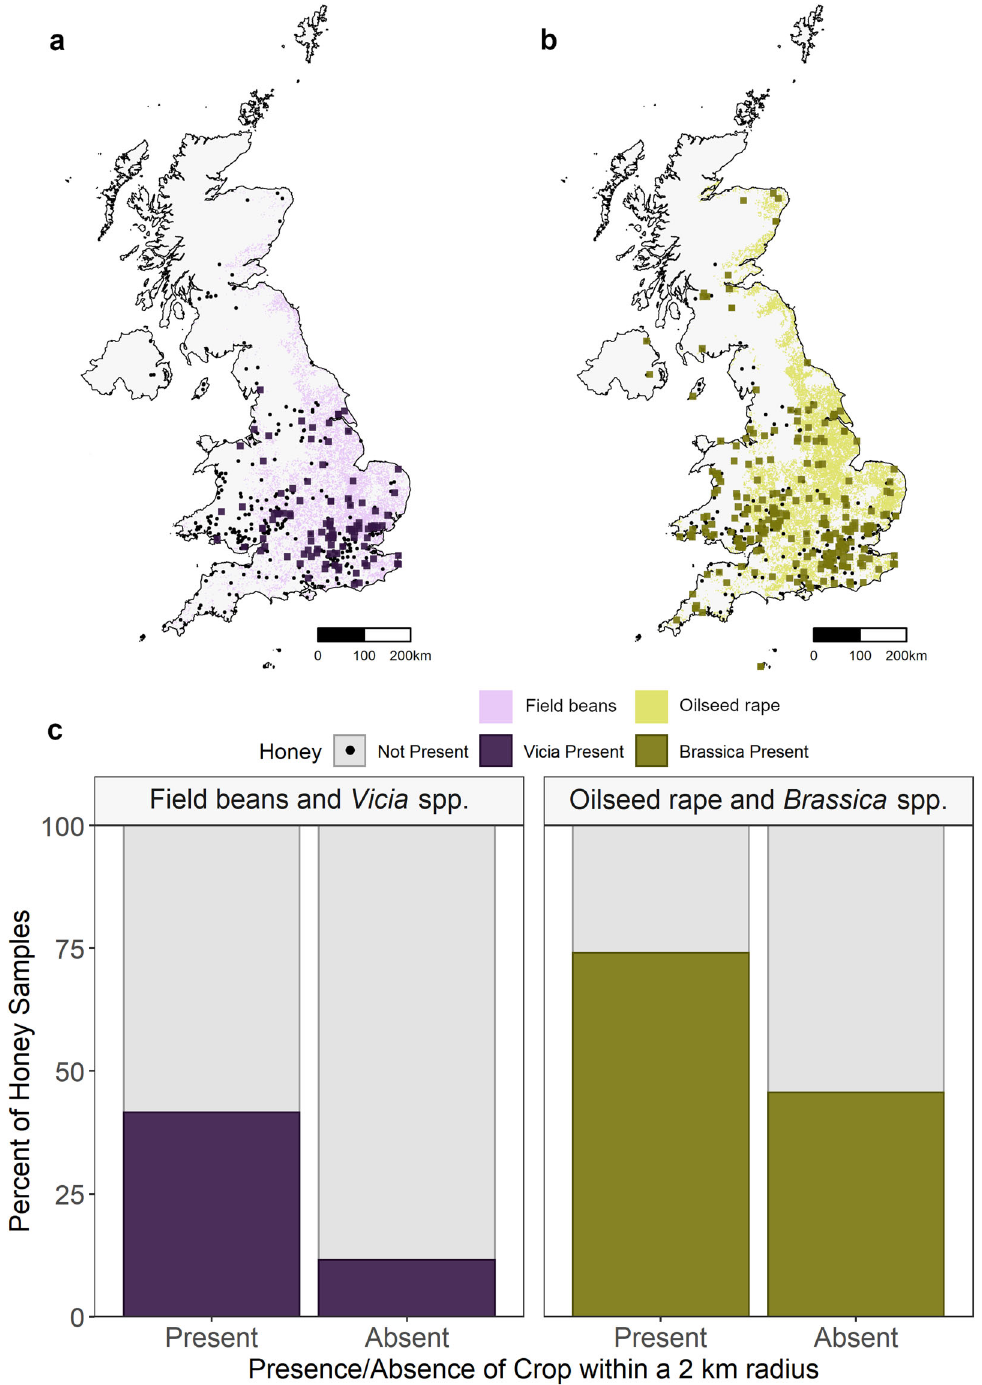
Fig. 4 Distribution of fi eld beans ( Vicia faba ) and oilseed rape ( Brassica napus ) in the UK and their presence within honey samples ( n = 424) detected using DNA metabarcoding. The distribution of fi eld beans ( a ) and oil seed rape ( b ) in 2017 from CEH Land Cover plus: Crops map is shown under honey samples with Vicia spp. ( a ) and Brassica spp. ( b ) present, as indicated by coloured squares. Black circles: not detected. c Vicia spp. were more likely to be detected in honey within a 2 km radius of fi eld beans ( x 2 = 52.83, d.f. = 4, p < 0.0001) and Brassica spp. within 2 km of oil seed rape ( x 2 = 50.71, d.f. = 4, p < 0.0001) (Supplementary Table